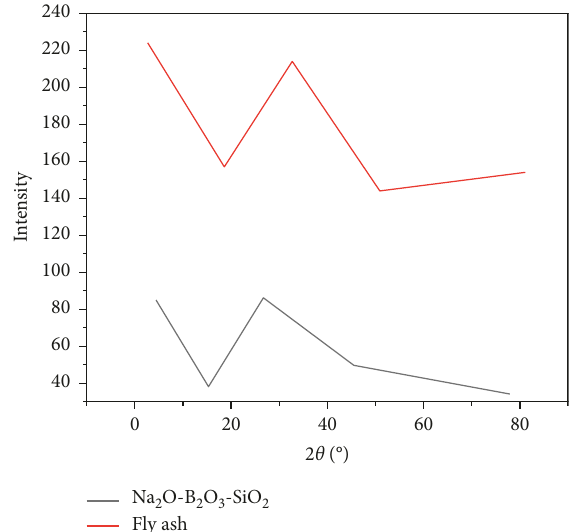
Figure 5: Surface reconstruction of silhouette